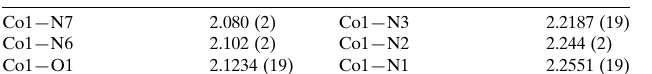
Selected bond lengths (A˚ ).